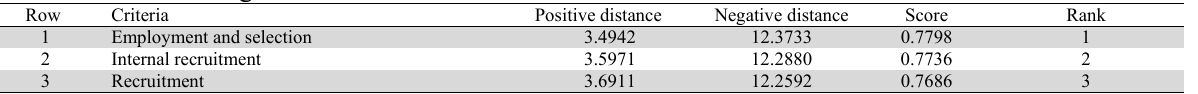
The results of ranking the recruitment and selection sub-criteria Row Criteria